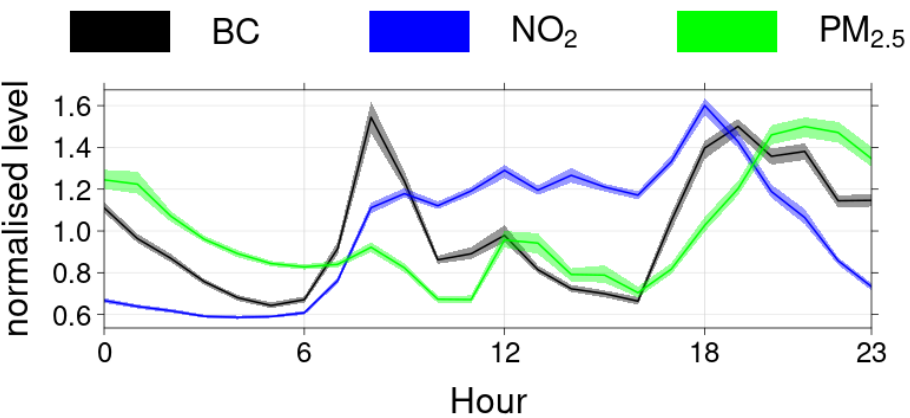
Figure 5. Normalised diurnal cycle (divided by the mean value) for all volunteers and for the three campaigns for BC, NO 2 , and PM 2.5 , respectively.